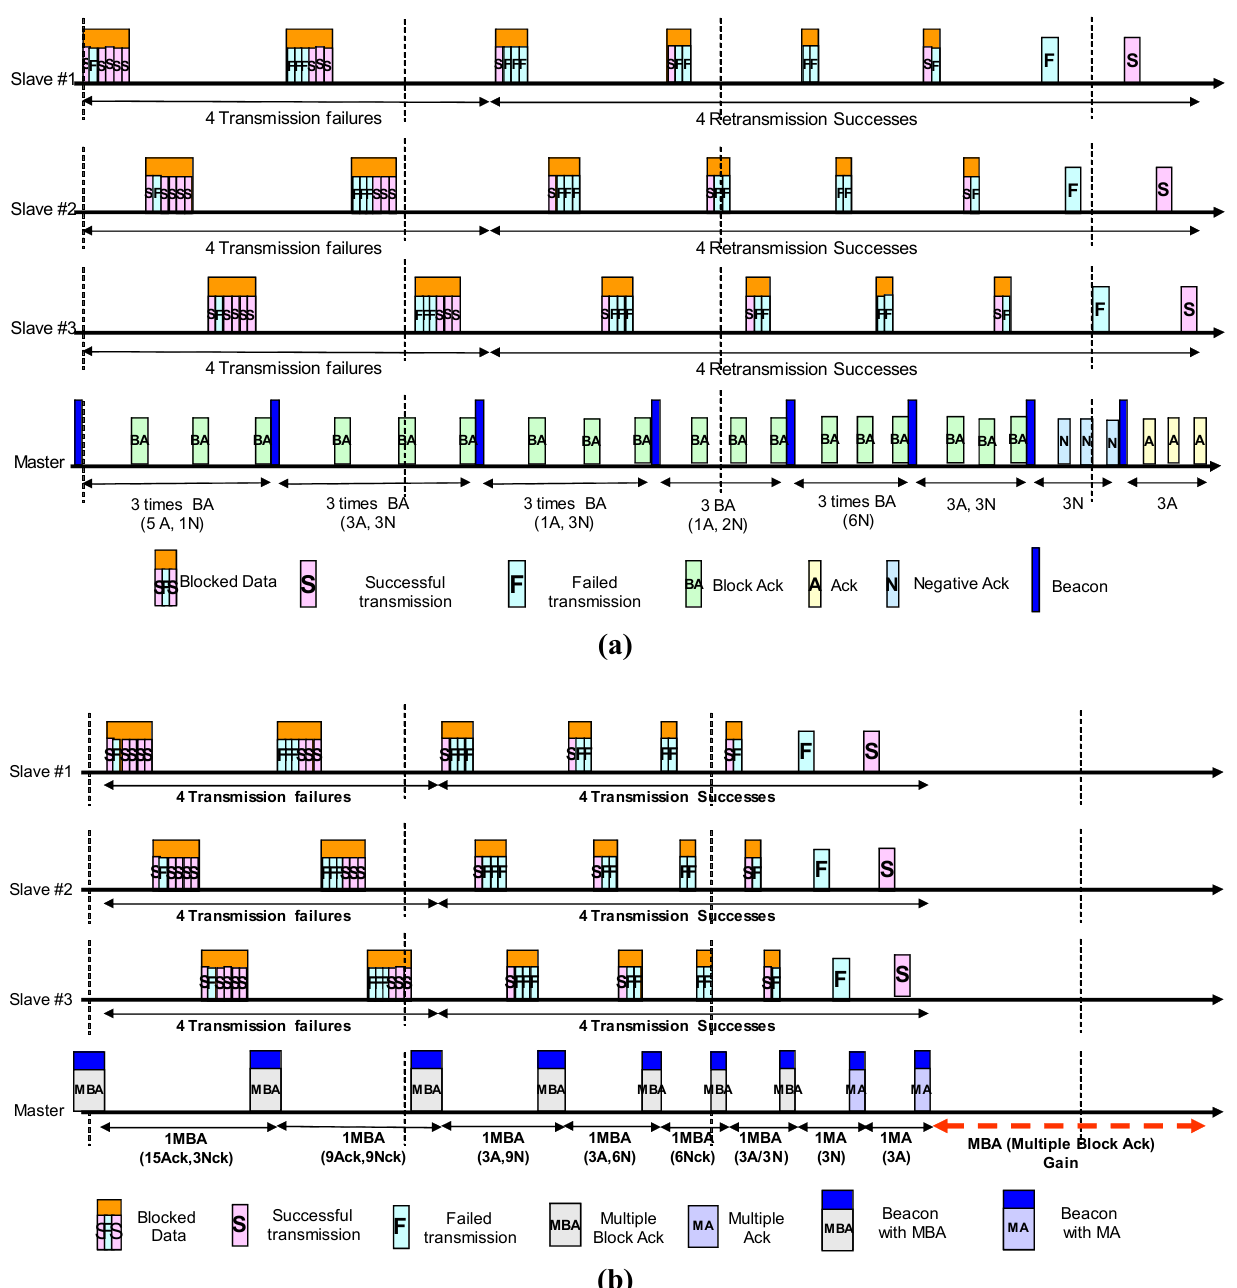
Figure 4. Comparison-2: BA (a) vs. MBA